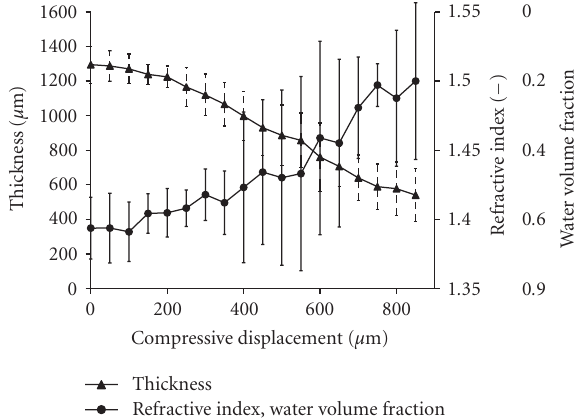
Figure 4: Ex vivo porcine skin thickness, refractive index, and water volume fraction during mechanical